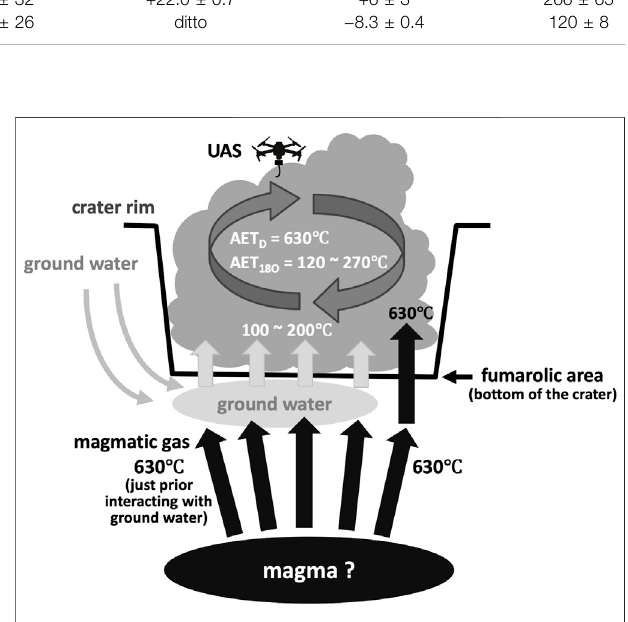
FIGURE 8 | Schematic diagram showing the cooling processes of the magmatic gas in the Nakadake crater, Aso volcano, to explain the observed discrepancy between AET D (630 ° C or more) and AET 18O (from 120 to 270 ° C) determined from the volcanic plume. While the AET D re fl ected the highest outlet temperature within the fumaroles in the crater, the observed AET 18O signi fi cantly lower than the AET D implied that the outlet temperatures were lower than the AET D in most of the fumaroles in the crater, probably due to the sudden cooling of the magmatic gas just beneath the crater in contact with ground